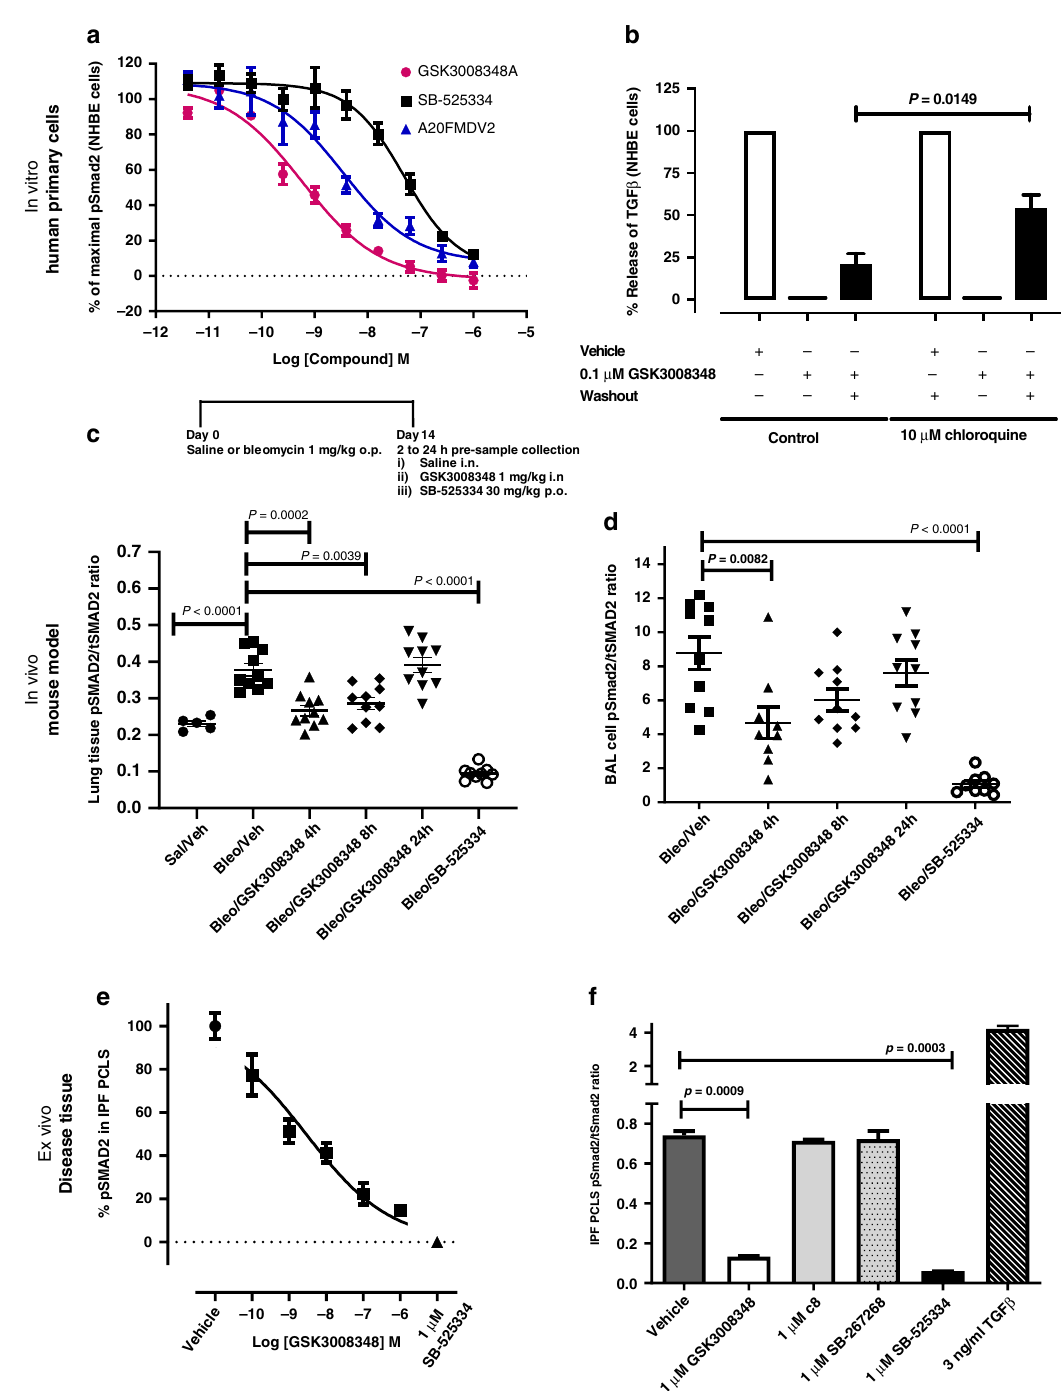
Fig. 5 Inhibition of α v β 6-mediated TGF β activation in vitro and in vivo by GSK3008348. a Concentration-dependent inhibition of pSmad2 levels in NHBE cells by GSK3008348, SB-525334 (TGF β R1 inhibitor), and A20FMDV2 (selective α v β 6 peptide) (mean ± SEM; n = 4). b Duration of action of the inhibition of GSK3008348 on TGF β -activation, and the effect of the lysosomal degradation inhibitor chloroquine, measured in a NHBE cell and TMLC (expressing the fi re fl y luciferase under the control of a TGF β -sensitive portion of the PAI-1 promoter) co-culture system (mean ± SEM; n = 4 – 8; Student ’ s t test). Effect of GSK3008348 (i.n.) versus SB-525334 (p.o.) on the levels of pSmad2 in c lung tissue and d BAL cells from bleomycin-treated mice (mean ± SEM; n = 5 – 10 animals per group; ANOVA with Fisher ’ s LSD post test comparisons). e Concentration-dependent effect of GSK3008348 on pSmad2 levels in IPF PCLSs (mean ± SD; three PCLSs in a single donor representative of four donors). f Levels of pSmad2 in PCLS from an individual IPF donor in the presence of α v integrin tool inhibitors (mean ± SEM; three PCLSs in a single donor representative of four donors). Sal/Veh Saline/Vehicle, Bleo/Veh Bleomycin/Vehicle. Source data are provided as a Source Data fi